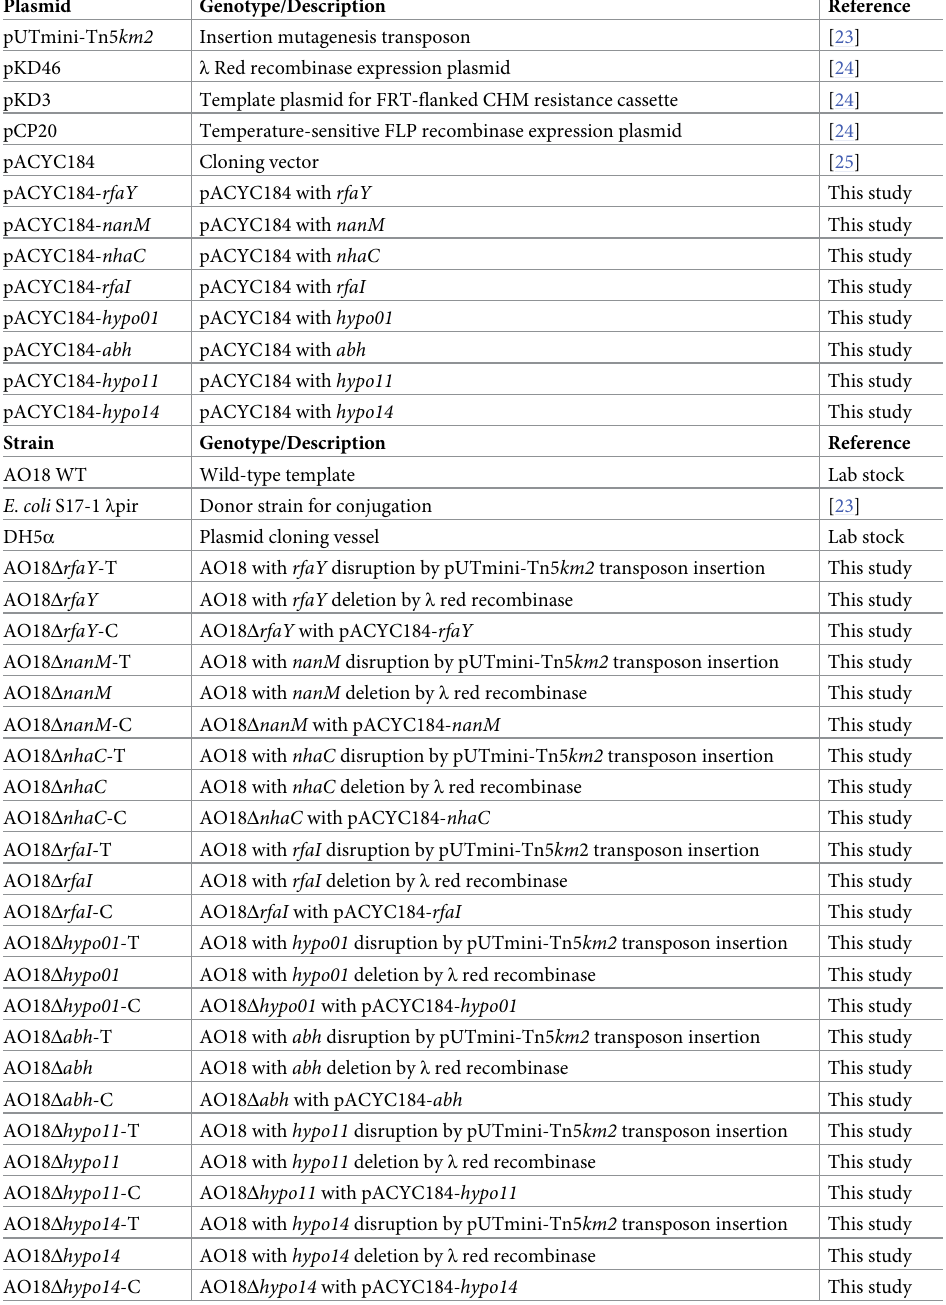
Table 1. Strains and plasmids in this study.